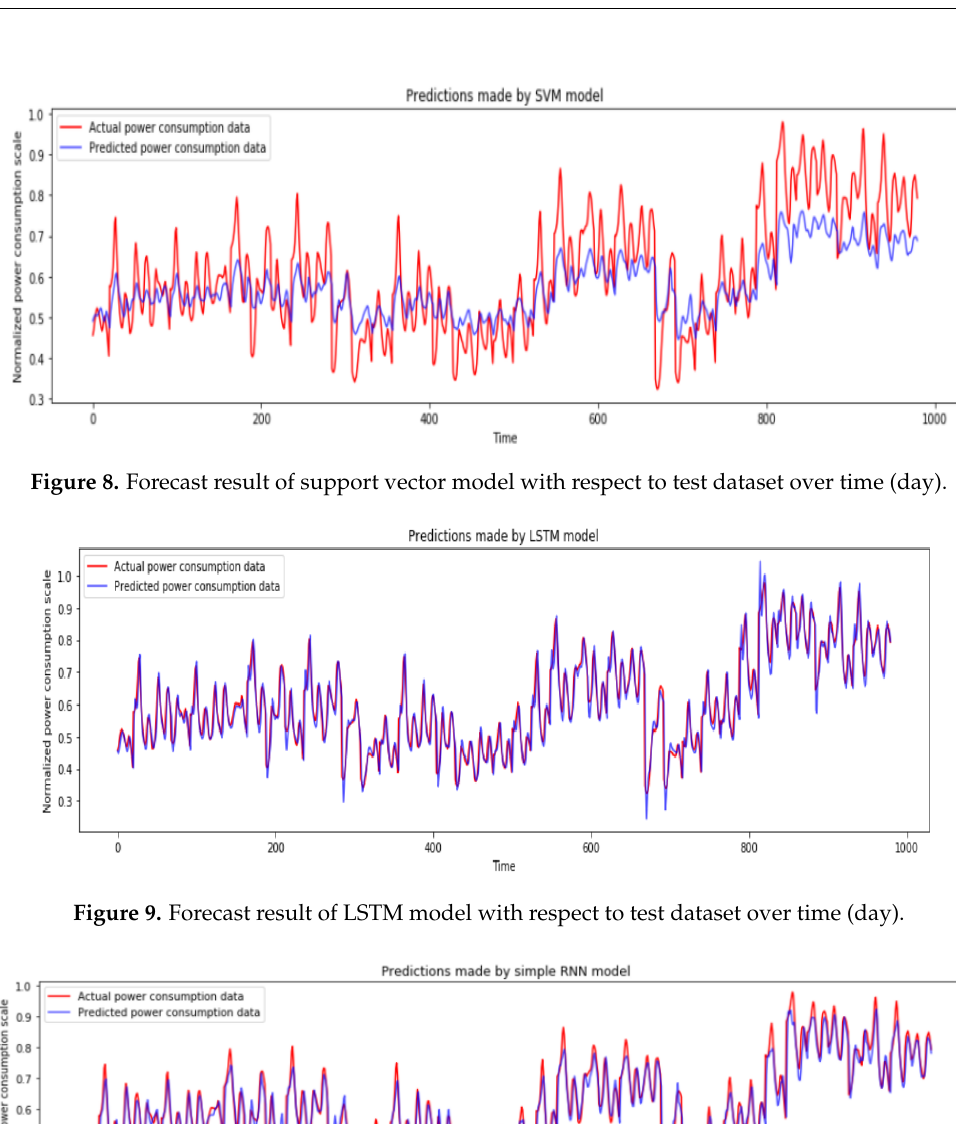
Figure 7. Forecast result of linear regression with respect to test dataset over time (day).